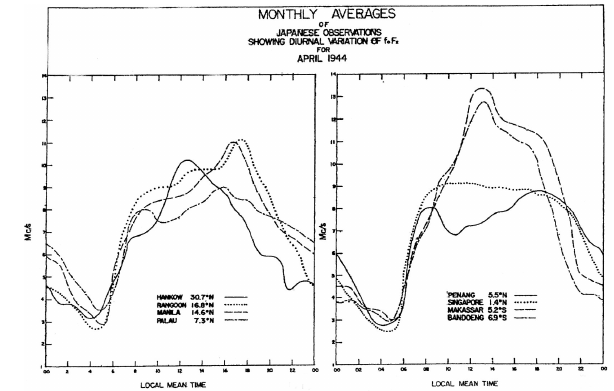
Figure 1. Daily variations of fo F2 observed at eight stations at or near the geomagnetic equator in 1944. Noon time peak is absent or weak at stations around the geomagnetic equator. This diagram is taken from “Report of Japanese Research on Radio Wave Prop- agation,” published by Pacific O ffi ce of the Chief Signal O ffi cer, General Headquarters, United States Army Forces, May